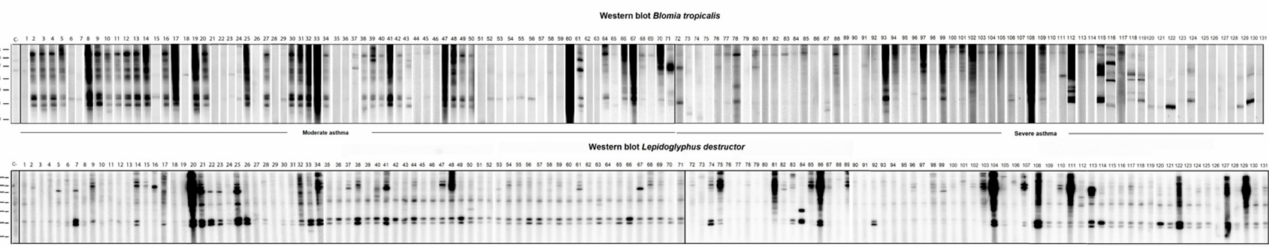
Figure 4. IgE Western blot of selected patients for Blomia tropicalis and Lepidoglyphus destructor allergenic extract. A marked IgE-binding intensity was found around 13, 14, 17, 30, 35, 50 and 55 kDa for Blomia tropicalis in the majority of subjects, and around 14–16 kDa mainly for patients with mild–moderate asthma and a more heterogenous repertoire including 14–16, 25, 40 and 50 kDa for Lepidoglyphus destructor in severe